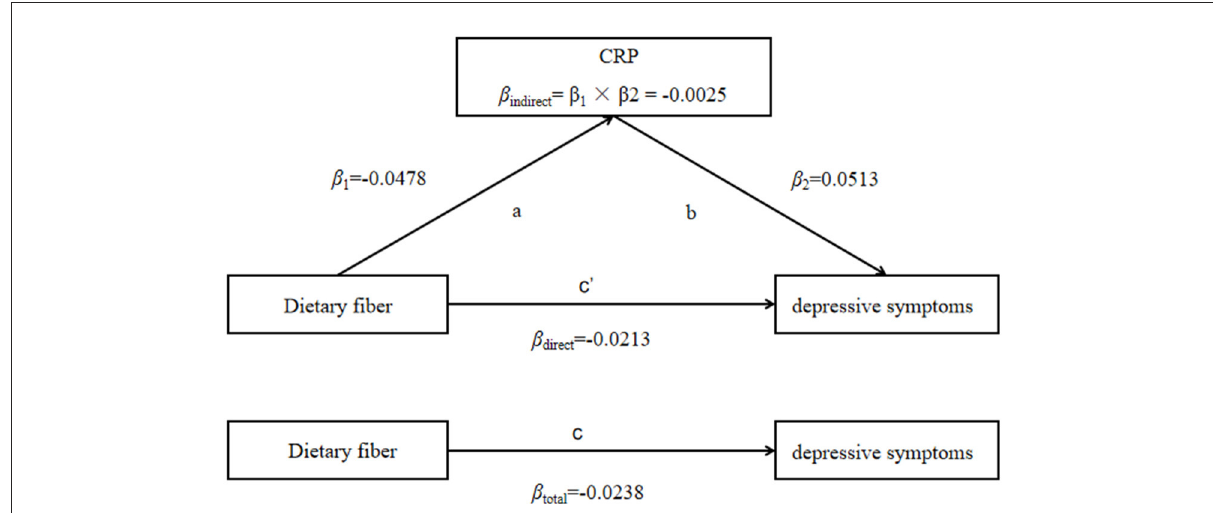
FIGURE1 CRP mediated the association between dietary fiber intake and depressive symptoms (PHQ-9 score as continuity variable), path ab represents the indirect effect, path c represents the direct effect, and path c represents the total effect.